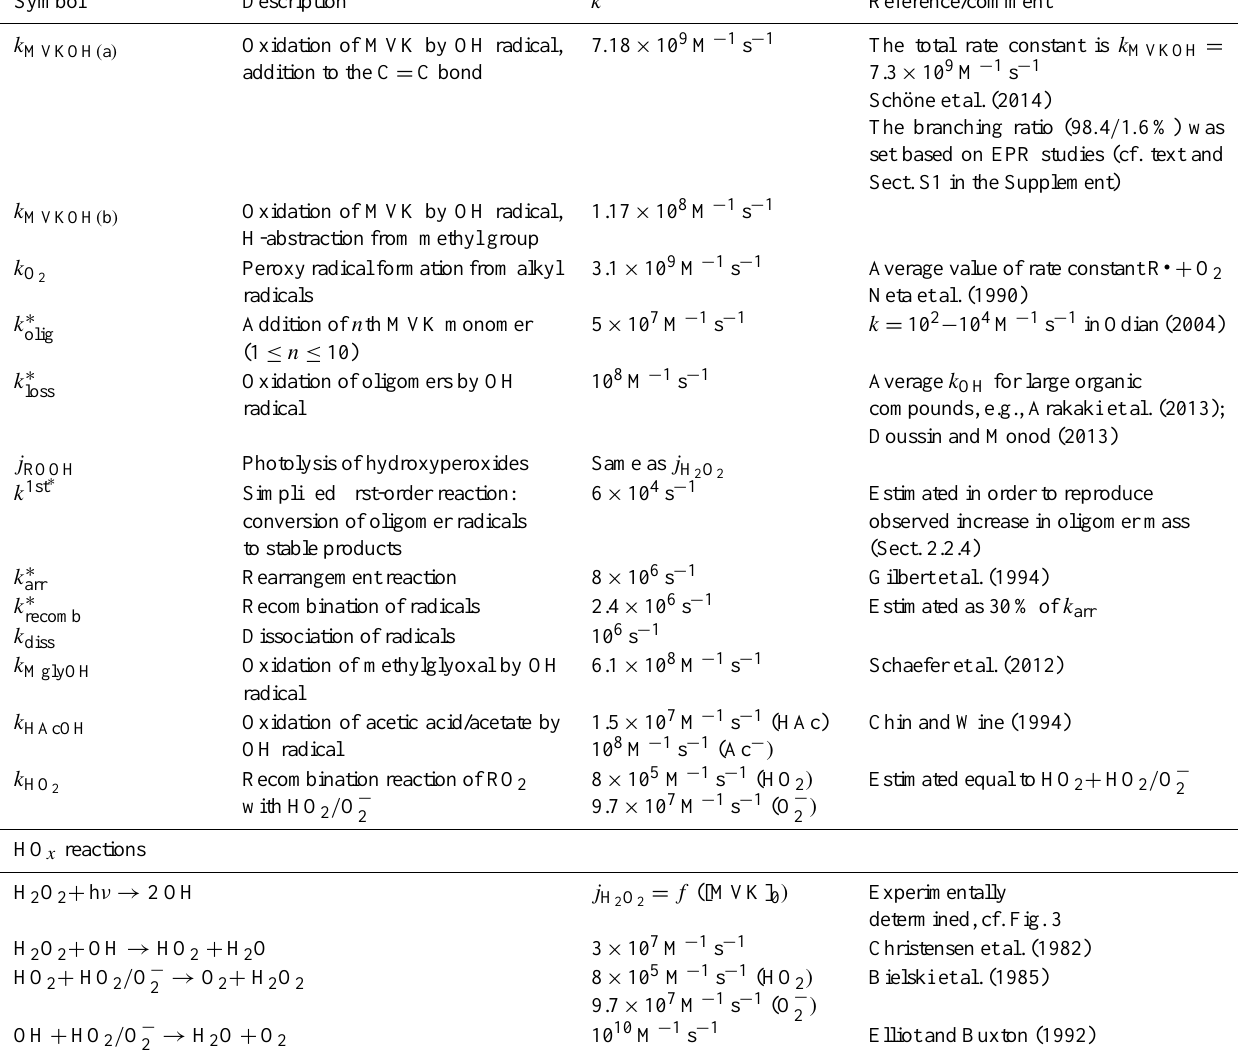
Table 1. Rate constants (at 298K) for the processes in Fig. 1. Symbol